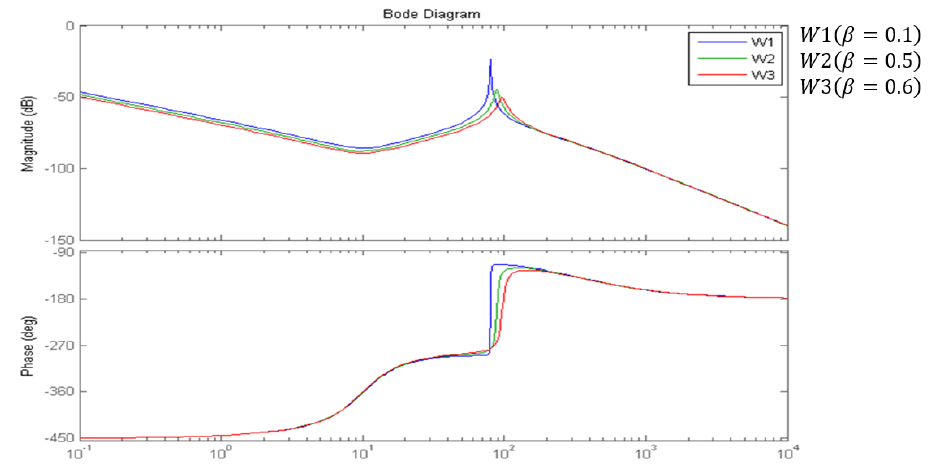
Figure 11. Frequency characteristics of the drive based on the traction motor.